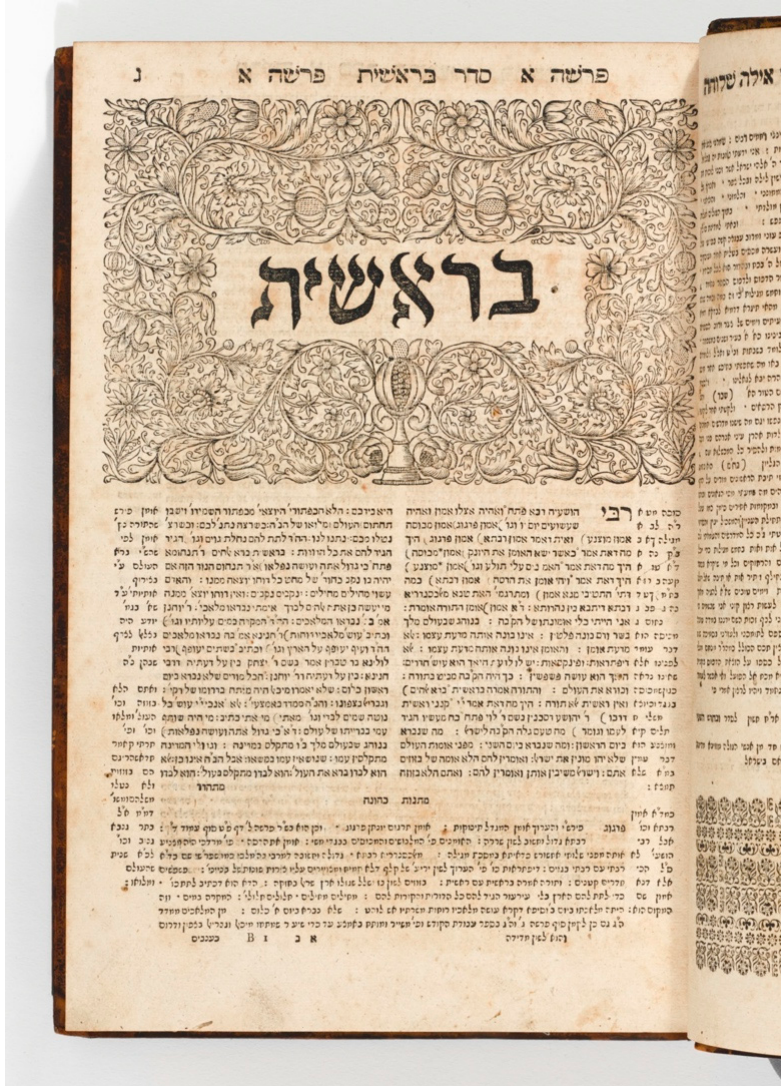
Figure 8. Sefer Rabot (Midrash Rabbah), Bereshit (Genesis); Marsh’s Library C.3.1.11.